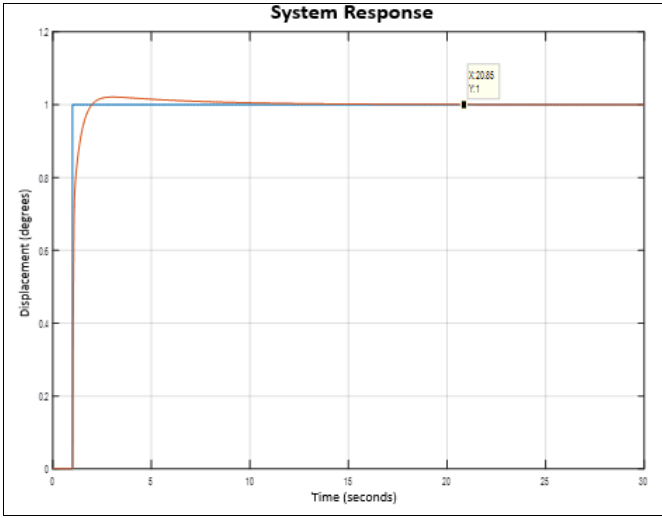
Figure 22: Response of the system with the designed